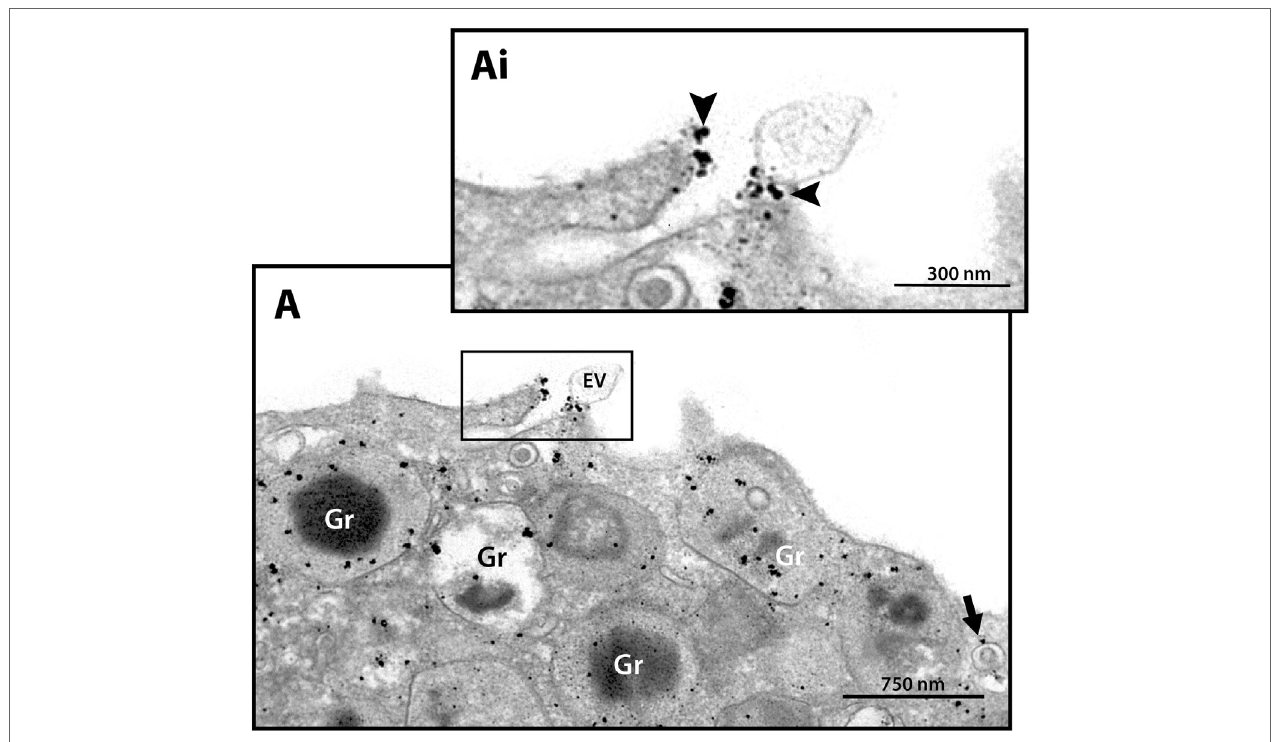
FigUre 5 | Extracellular immunodetection of IFN- γ in human eosinophils. A representative electron micrograph shows IFN- γ at the cell surface (arrowheads). A labeled extracellular vesicle (EV) is also observed. The arrow indicates an IFN- γ -positive EoSV. Note the clear labeling at its delimiting membrane. Secretory emptying granules (Gr) are prominently labeled. The boxed area in (a) is shown in (ai) in higher magnification. Eosinophils were isolated from the peripheral blood, stimulated with CCL11 and prepared for pre-embedding immunanogold